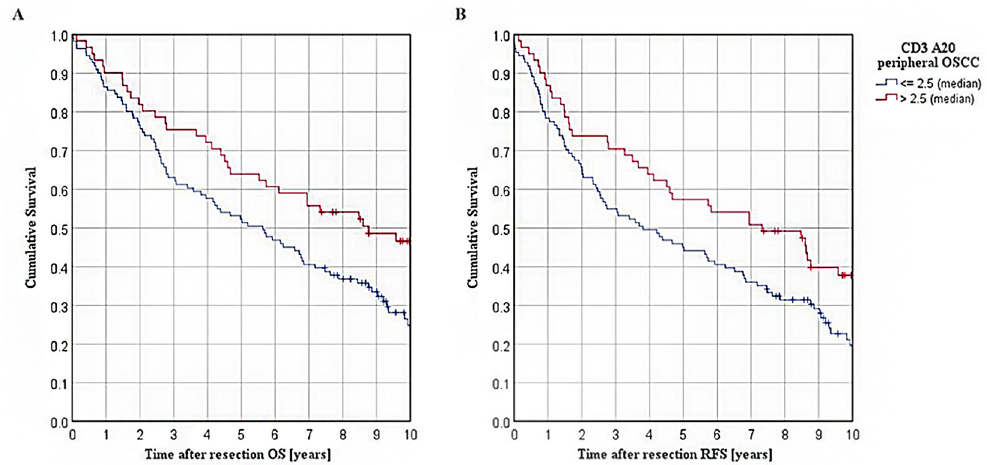
Figure 3. Survival in TMA cohort of OSCC patients: ( A ): Kaplan–Meier curves for OS in patients with varying extent of A20 expression within stromal CD3+ T cells of peripheral tumor, separated by a median cut-off ( n = 172, p = 0.017); ( B ): Kaplan–Meier curves for RFS in patients with varying extent of A20 expression within stromal CD3+ T cells of peripheral tumor, separated by a median cut-off ( p = 0.020).